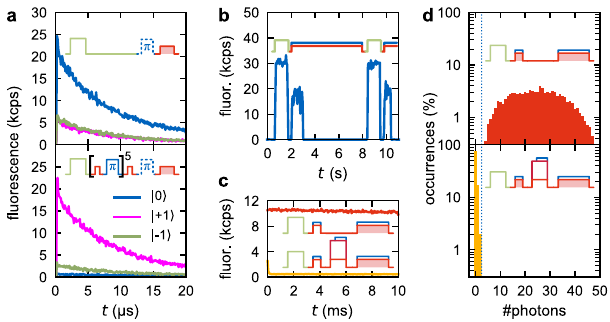
Fig. 2 Spin- and charge-state stability of the deep NV center. a Average fl uorescence under optical pumping with a 637 nm laser being resonant to the main |0 〉 transition. In the upper panel, the NV center was initialized to | 0 〉 with (70 ± 1)% probability by a simple green laser pulse, followed by no MW excitation (blue) or by a π -pulse on either the |0 〉 ↔ | + 1 〉 or |0 〉 ↔ | − 1 〉 transition (magenta and green curve). The lower panel displays the same measurement after initializing to | + 1 〉 with (88 ± 2)% probability using the explicit spin initialization protocol presented in Fig. 1c. The insets are sketches of the sequence used for the upper and lower panels.